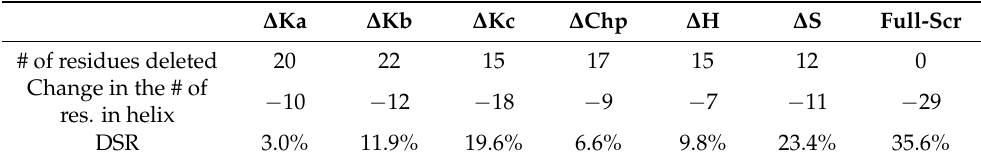
Table 1. Effects of the deletions on the helical propensity of ERD14. ∆ Ka ∆ Kb ∆ Kc ∆ Chp ∆ H ∆ S Full-Scr # of residues deleted 20 22 15 17 15 12 0 Change in the # of − 10 − 12 − 18 − 9 − 7 − 11 − 29 res. in helix DSR 3.0% 11.9% 19.6% 6.6% 9.8% 23.4%